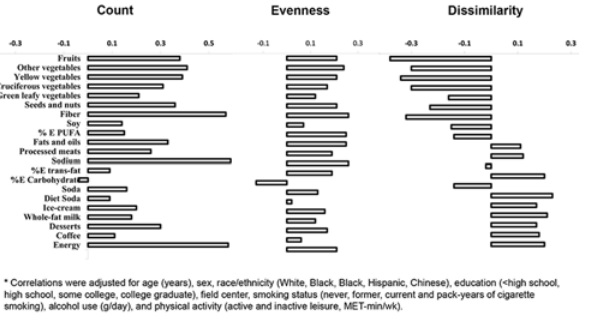
Fig 1. Spearman correlations between dietary factors and diet diversity metrics in 2,505 multi-ethnic US adults.